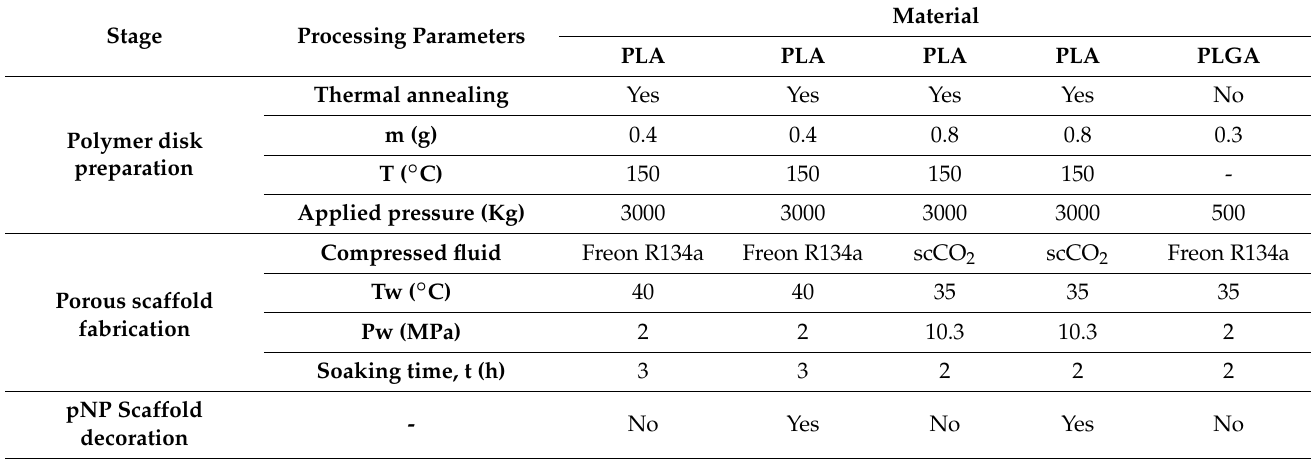
Table 1. Experimental conditions for preparing the porous polymeric matrices.